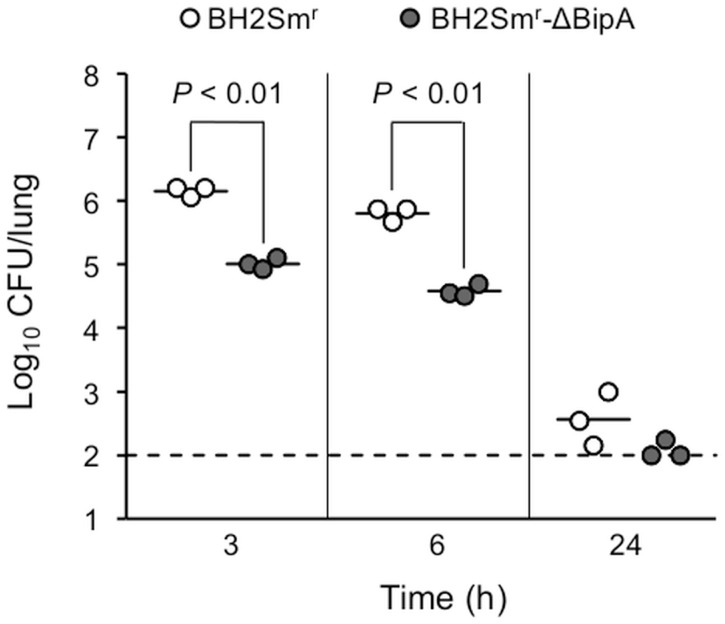
Initial colonization of BipA mutant in murine lungs.Groups of three BALB/c mice were intranasally infected with the BipA mutant BH2Smr-ΔBipA or its parental strain BH2Smr. The colonization levels were assessed after 3, 6, and 24 h. Each symbol represents one mouse, and horizontal lines represent the mean number of CFU recovered. Statistical significance was determined using Student’s t-test. The dashed line indicates the lower limit of detection (100 CFU/lung). The lung CFUs in two mice infected with BH2Smr-ΔBipA were below the limit of detection at 24 h post-infection.